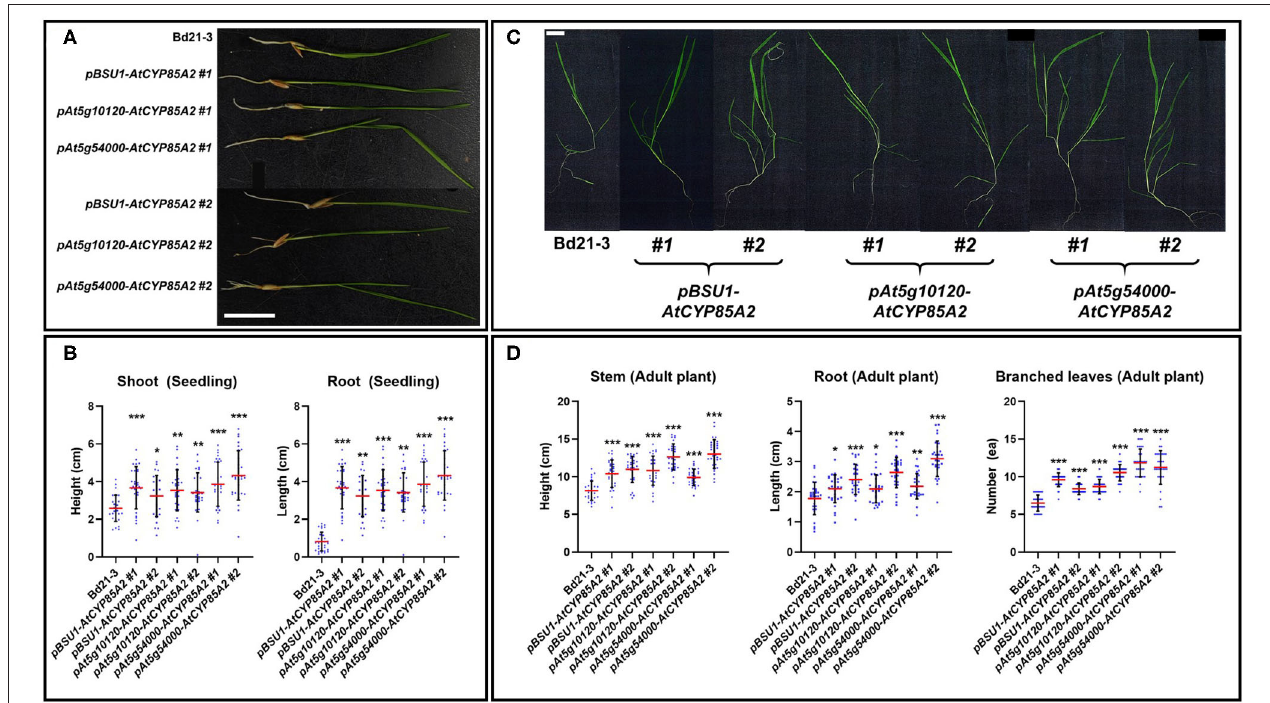
FIGURE 6 | Phenotypic alterations of transgenic Brachypodium in vegetative growth. (A) Seedling growth of wild type and transgenic Brachypodium. Seedlings were grown in MS medium for 3 weeks. (B) Length of shoot and root in seedling of wild type and transgenic Brachypodium. (C) Phenotype of adult plants in wild type and transgenic Brachypodium. Plants were grown in soil for 6 weeks. (D) Length of stem, root, and number of branched leaves in wild type and transgenic Brachypodium. #1 and #2 represent two different lines for three transgenic plants. The scale bar in (A) and (C) indicates 1cm. Each dot in (B) and (D) indicates individual data. Red and black line represents the mean of the individual measurements and the standard deviation (S.D.), respectively. The asterisks indicate the statistical significance of the Student’s t -test: * ( P < 0.05), ** ( P < 0.01), and *** ( P <